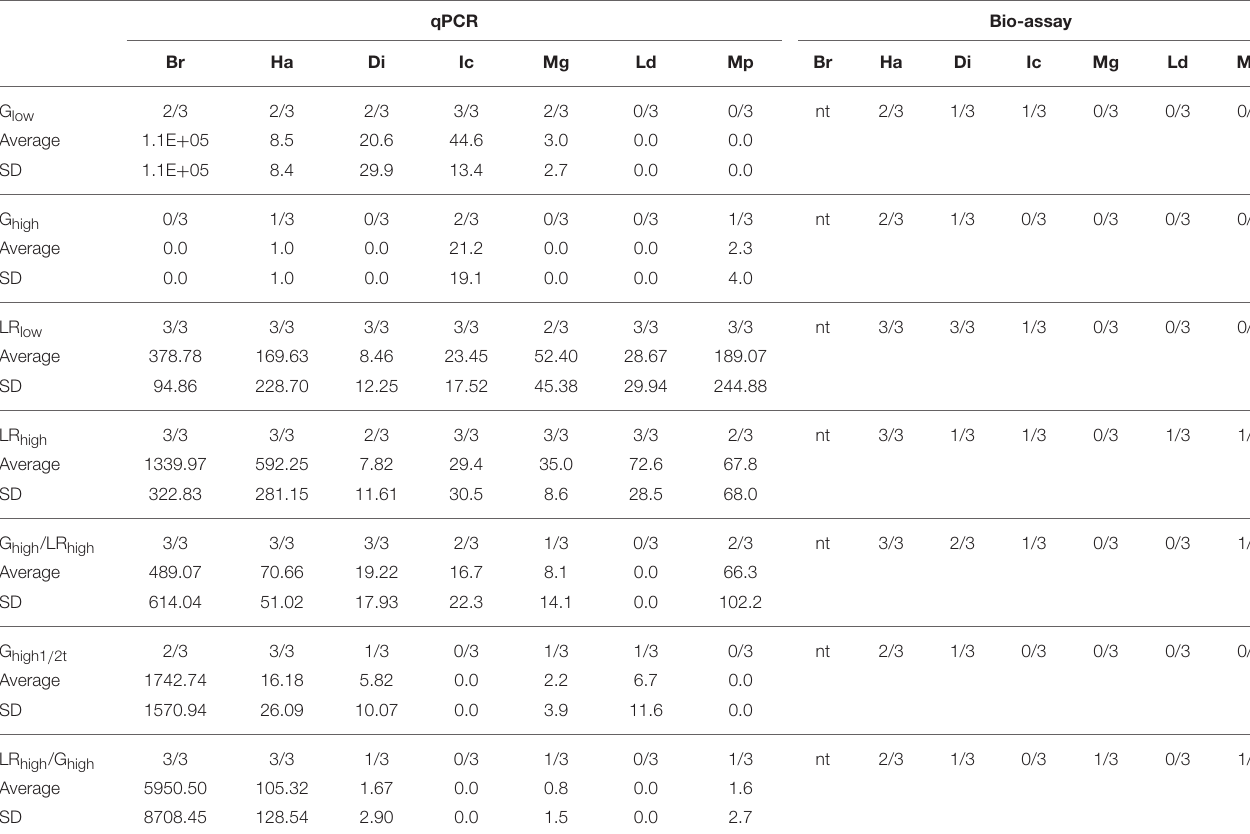
TABLE 3 | Parasite load (number of bradyzoites per 1E + 08 cells) by qRT-PCR after inoculation with two T. gondii strains, in comparison with bio-assay (number of positive/total